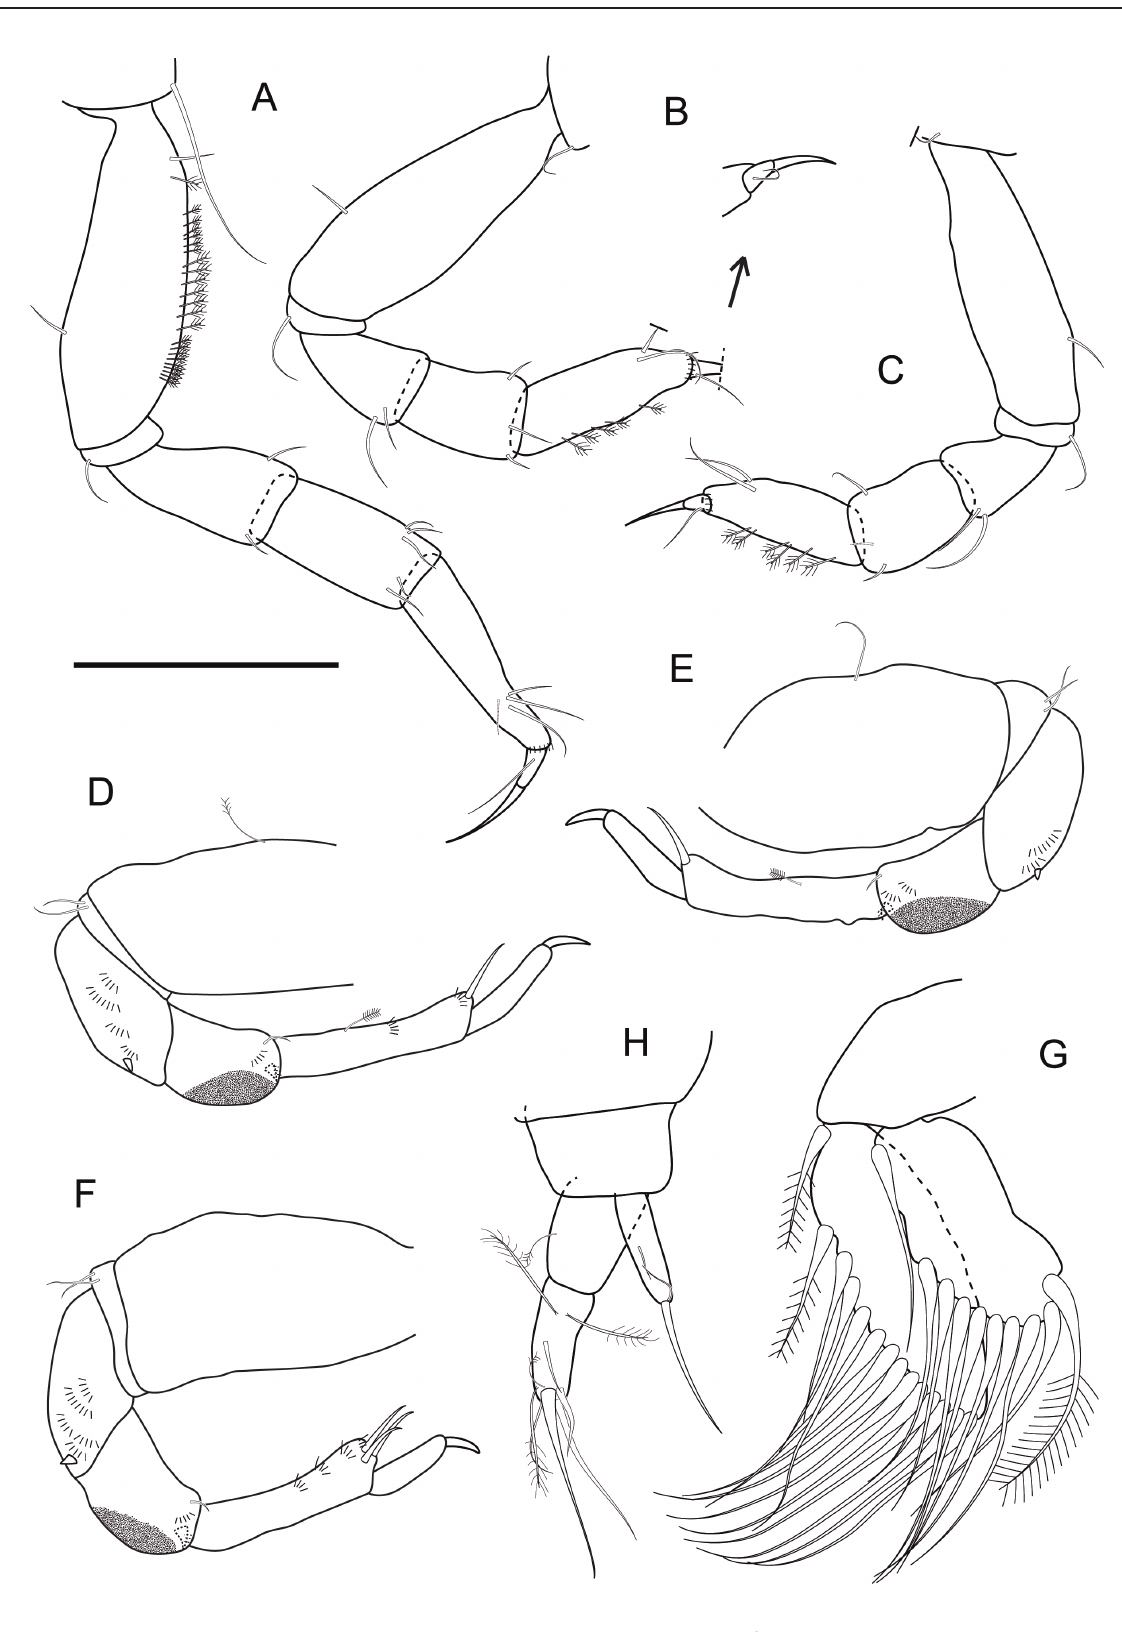
Fig. 7. Typhlotanais longiseta sp. nov., paratype (MZUSP 38015), ♀, dissected. A–F . Pereopods 1–6. G . Pleopod. H . Uropod. Scale bar = 0.1